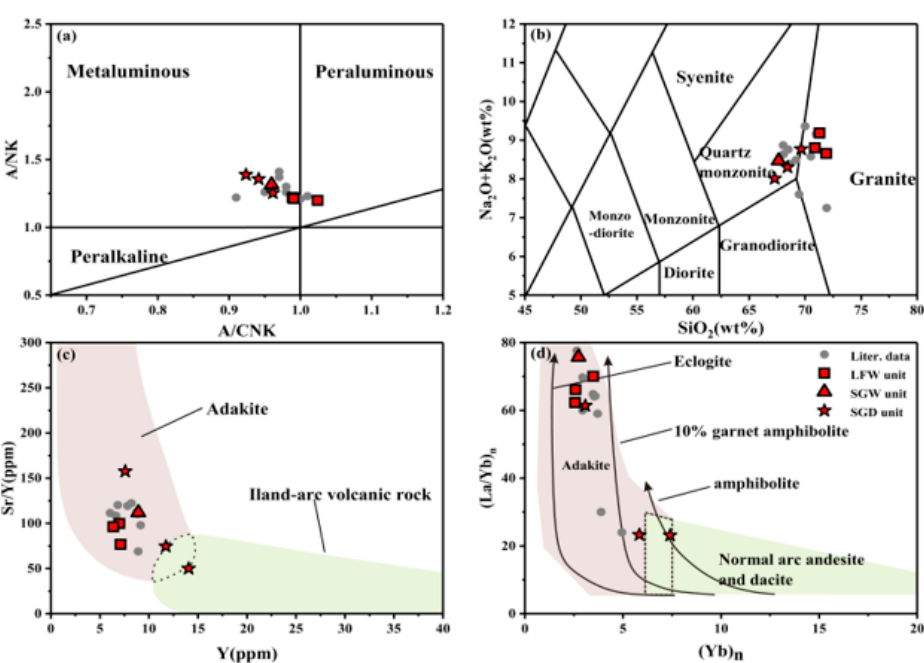
Figure 5. ( a ) A/CNK vs. ANK, ( b ) SiO 2 vs. Na 2 O + K 2 O [46,47], ( c ) Y vs. Sr/Y [18], ( d ) (Yb)n vs. (La/Yb) n [48]; the curves in Figure 5d indicate the degree of melting.